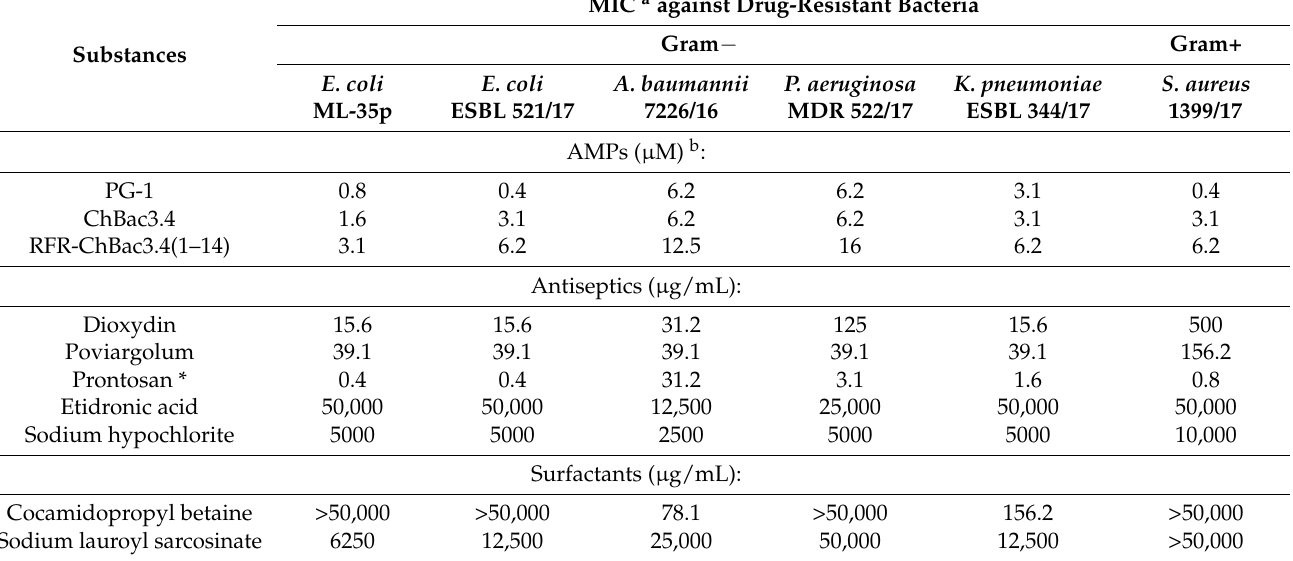
Table 1. Antimicrobial activity of AMPs, antiseptics, and surfactants alone against drug-resistant clinical isolates and E. coli ML-35p laboratory